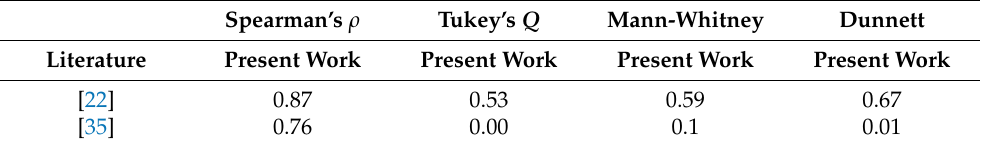
Table 3. The Speraman’s correlation coefficient as well as the probabilities the reconstructed CT image to be similar to Jumanzarov et al. [22] and van Aarle et al. [35] consistent with Tukey’s Q, Mann–Whitney and Dunnett post hoc